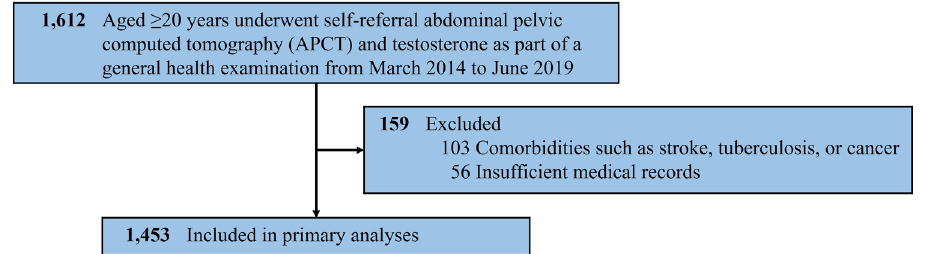
Figure 1. Overview of the study